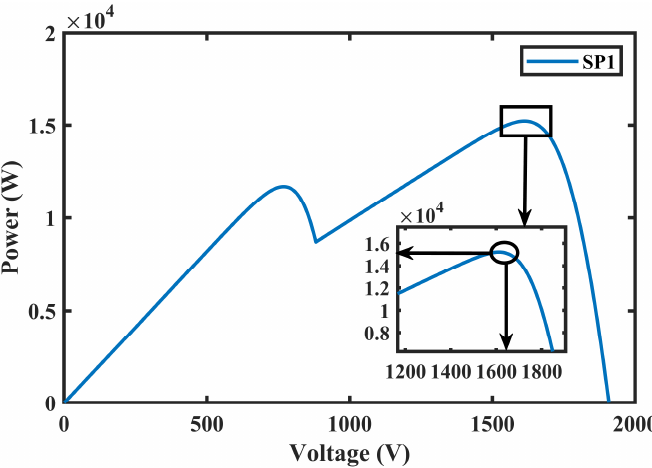
Figure 11. Voltage and power at SP1.